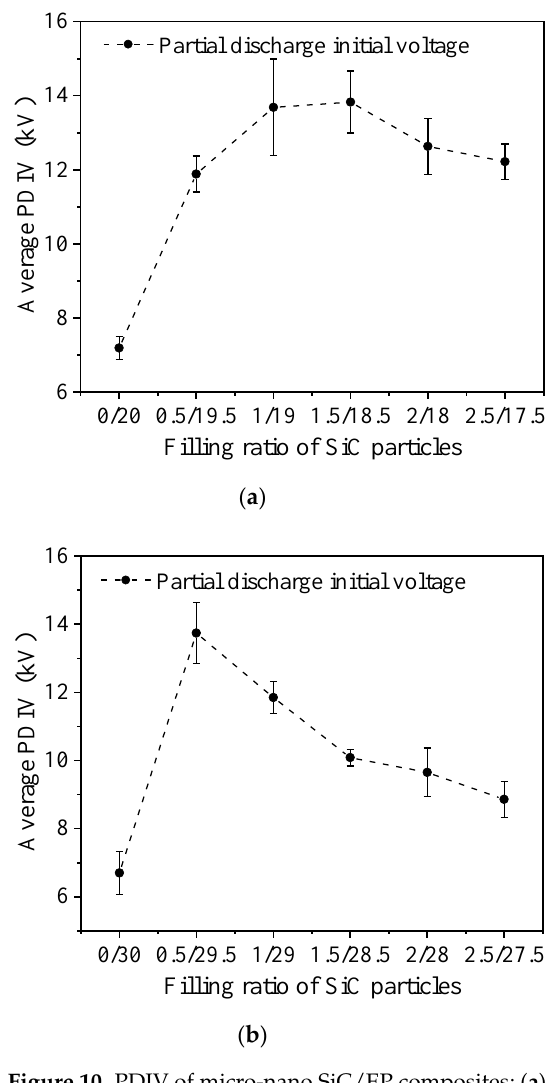
Figure 10. PDIV of micro-nano SiC/EP composites; ( a ) The total filling ratio of 20 wt%; ( b ) The total filling ratio of 30 wt%.